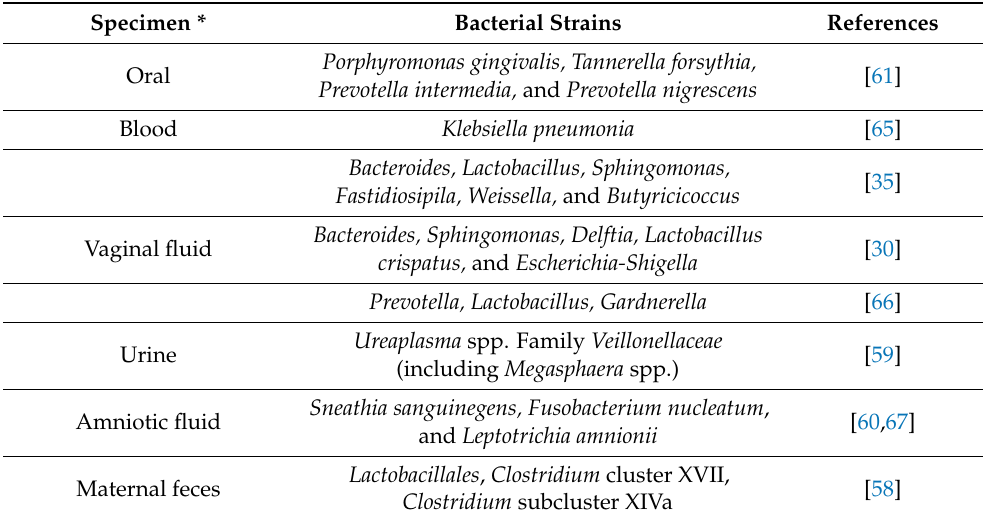
Table 1. Microbial richness in preterm